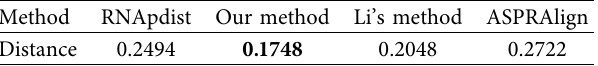
Supplementary Figure S1: The cluster analysis graph of 100 noncoding RNA sequences generated by Li’s method. Supplementary Figure S2: The cluster analysis graph of 100 noncoding RNA sequences generated by RNApdist .